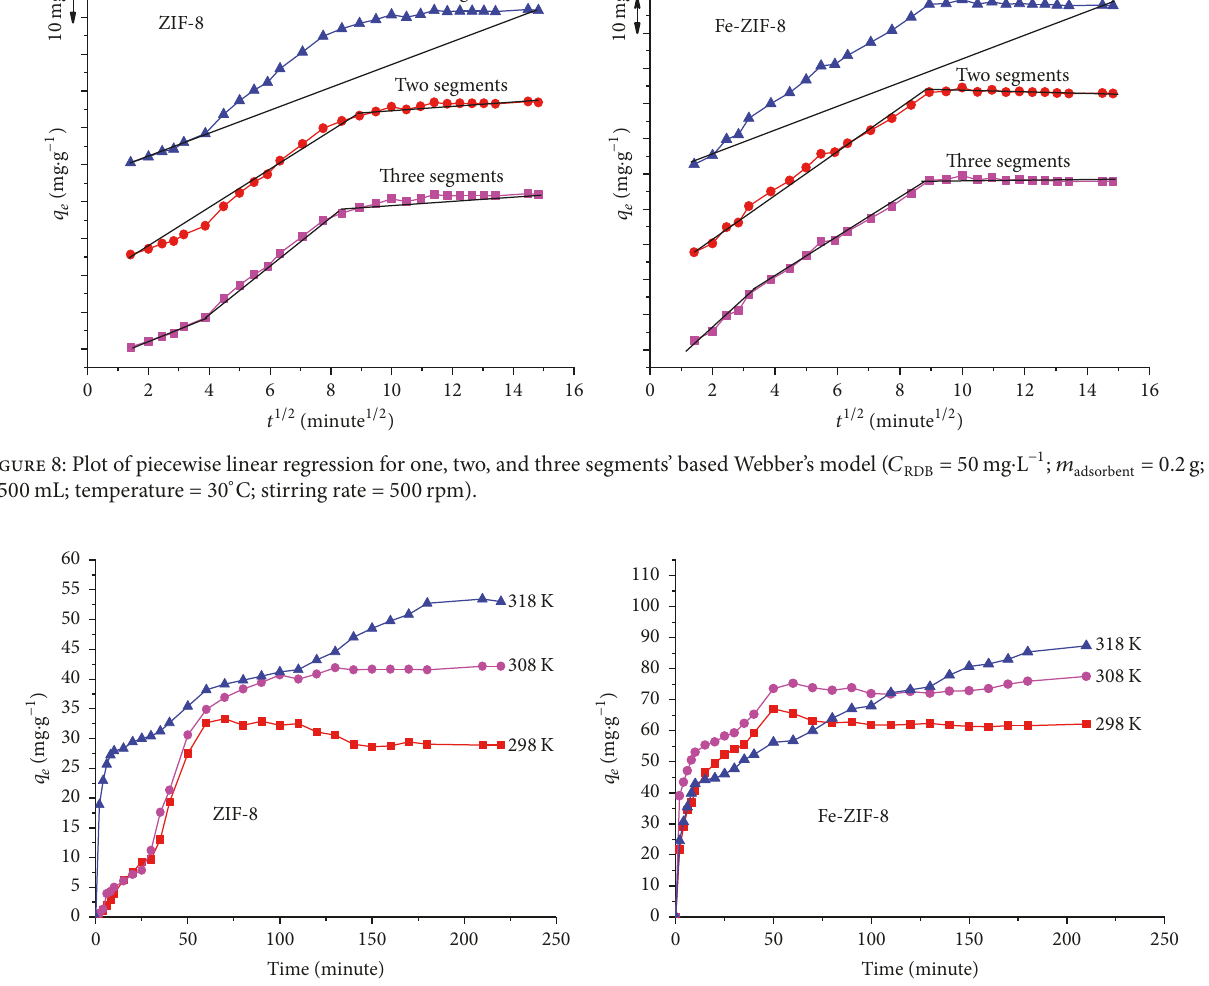
= 30–50 mg ⋅ L −1 , 𝑚 = 0.2 g, 𝑉 = RDB ZIF −8 RDB